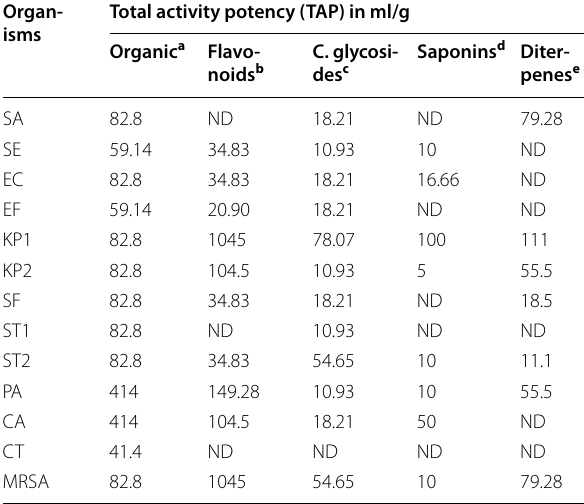
Table 5 Total Activity Potency (TAP) of Gymnema sylvestre organic extract and its partially purified